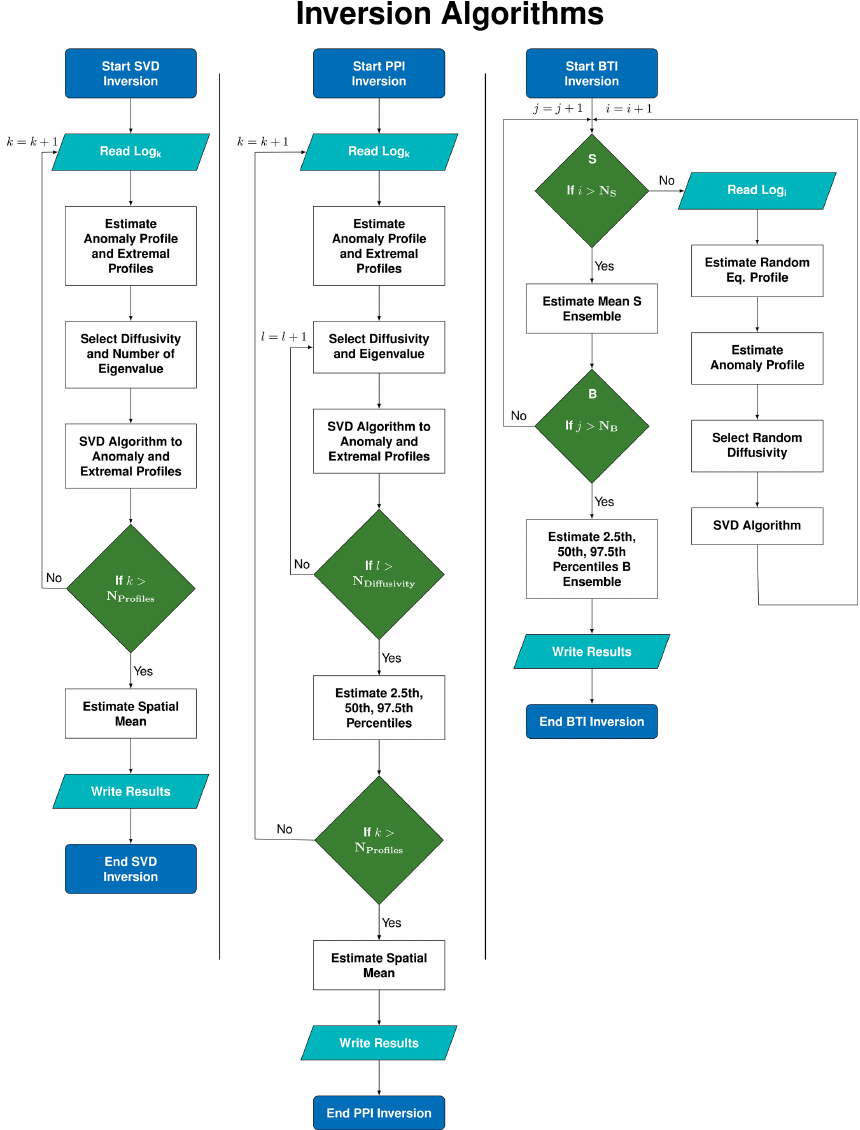
Figure 2. Flowchart diagram of the three methods used here to retrieve STP inversions: SVD (left), PPI (center), and BTI (right). All three methods are based on SVD inversions, but consider different approaches to estimate uncertainties. SVD and PPI methods invert three anomaly profiles from each log: the anomaly estimated from the quasi-equilibrium temperature profile and two extremal anomaly profiles estimated using the error in the determination of the quasi-equilibrium temperature profile, which provide the best estimate and the uncertainty